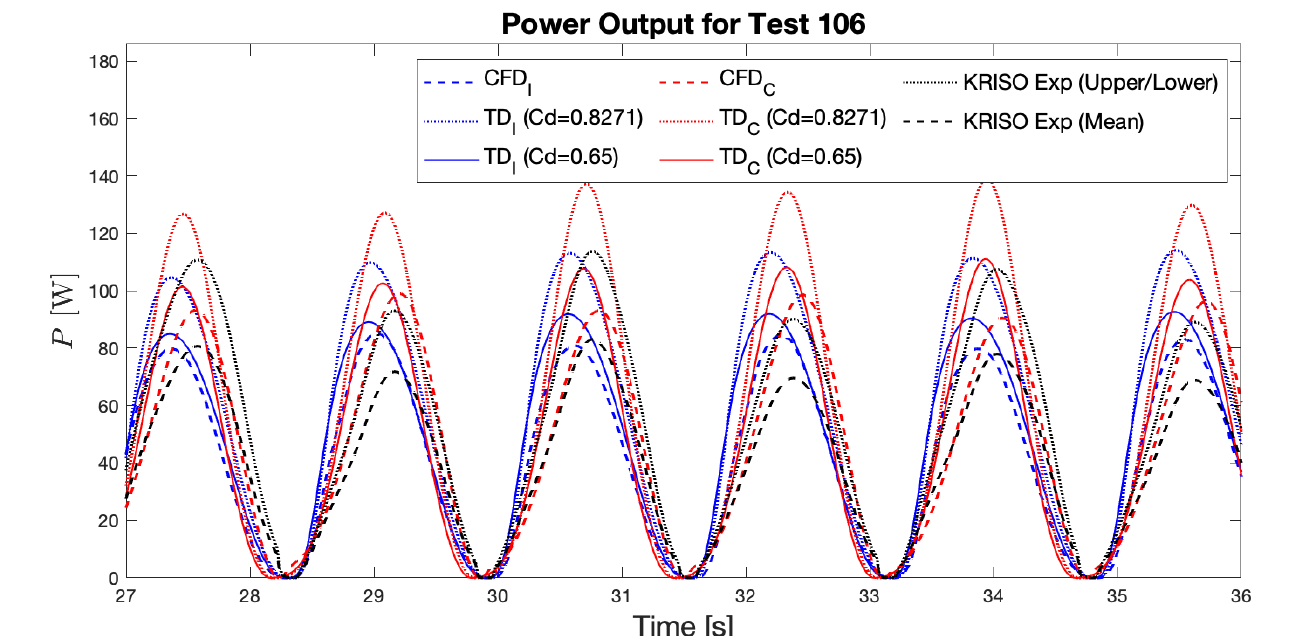
Figure 28. Estimated power output from the KRISO experiment, CFD simulations, and potential flow solutions for Test